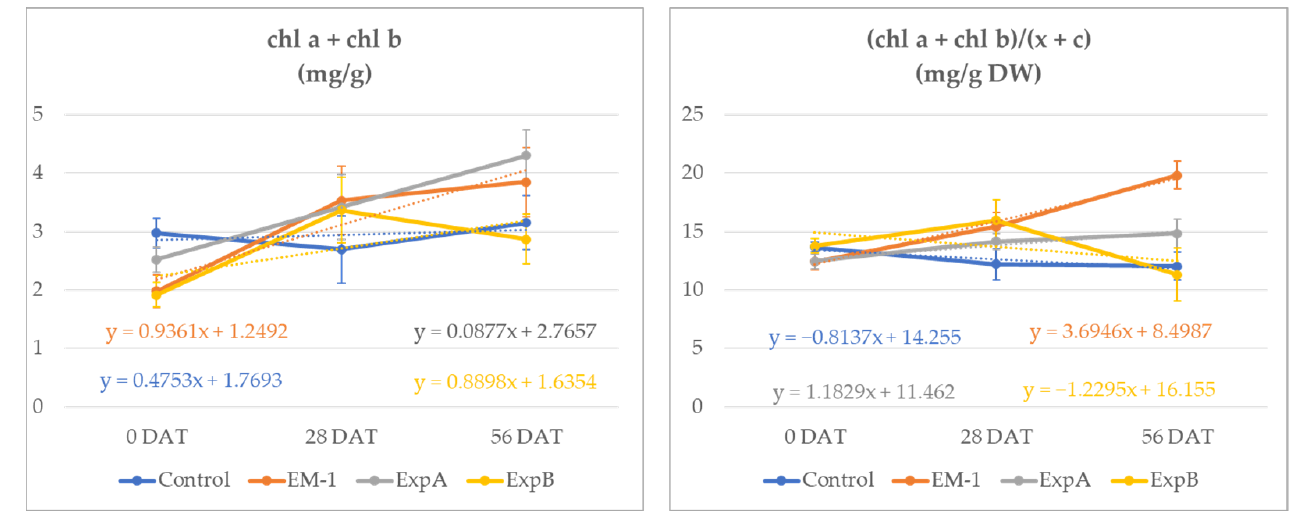
Figure 1. Total chlorophyll content (Chl a + Chl b ) (mg/g DW) and ratio of Chls a and b to total carotenoids (a + b)/(x + c) (mg/g DW) in the leaf material of creeping bentgrass from 0 to 56 DAT for the untreated control, EM ‐ 1, ExpA and ExpB.